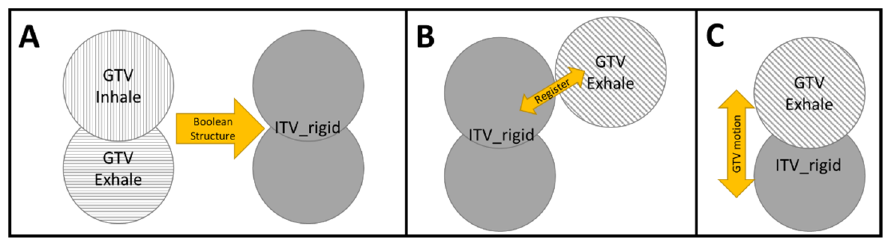
Figure 5. ITV planning and treatment strategy for compression patients. ( A ) An ITV is created from inhale and exhale simulation scans and set as a rigid structure. ( B ) The rigid structure can be registered to the GTV from the navigator-triggered image along the superior edge. ( C ) GTV motion can be verified using motion monitoring.